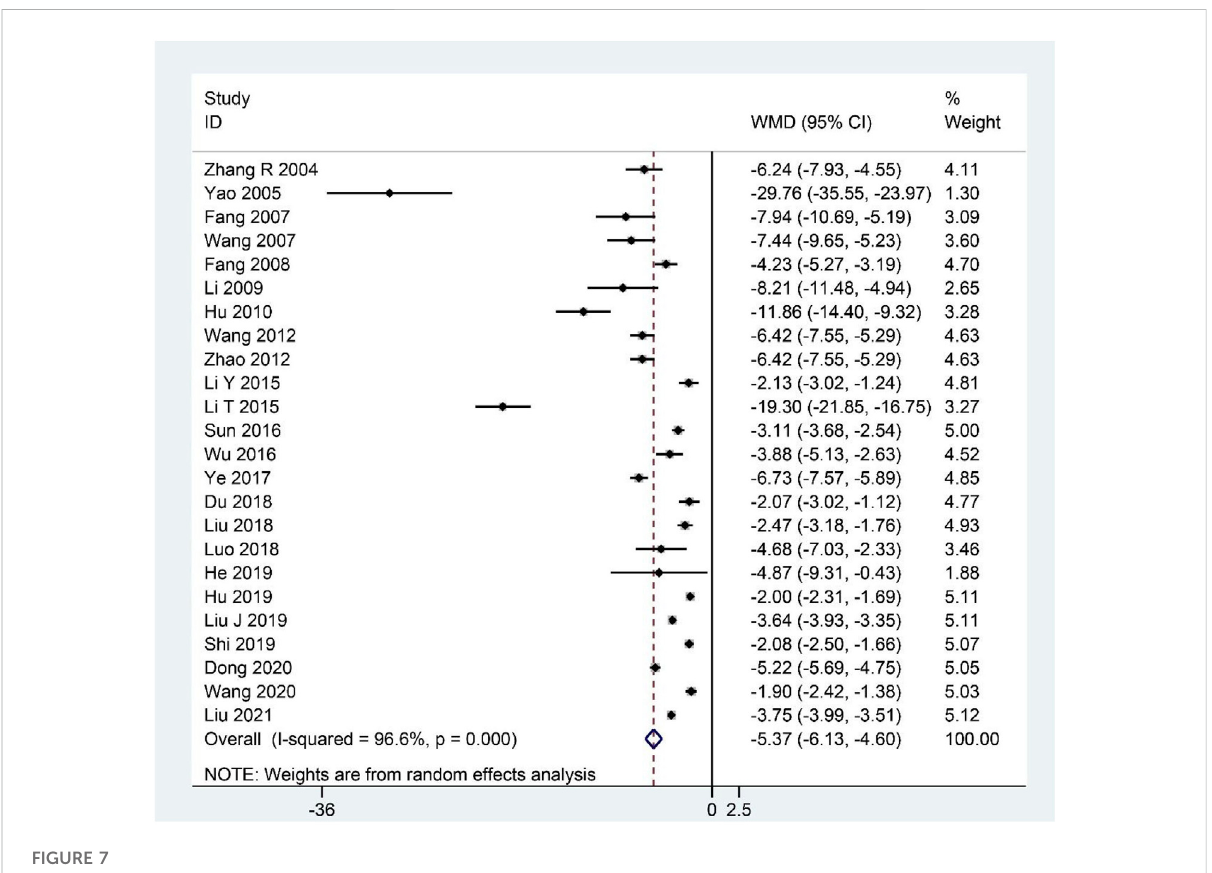
FIGURE 7 Forest plot for clinical symptom